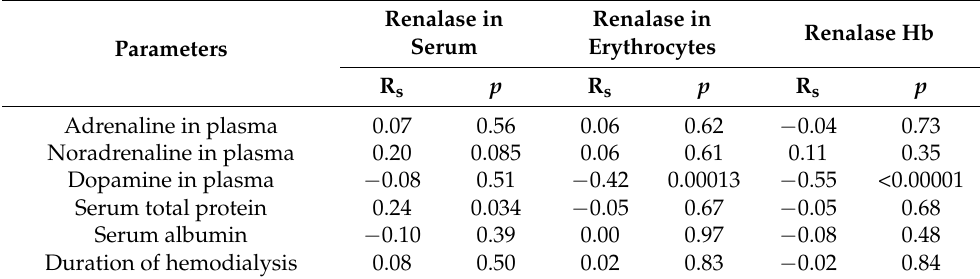
(ng of renalase/1 g haemoglobin in lysates).